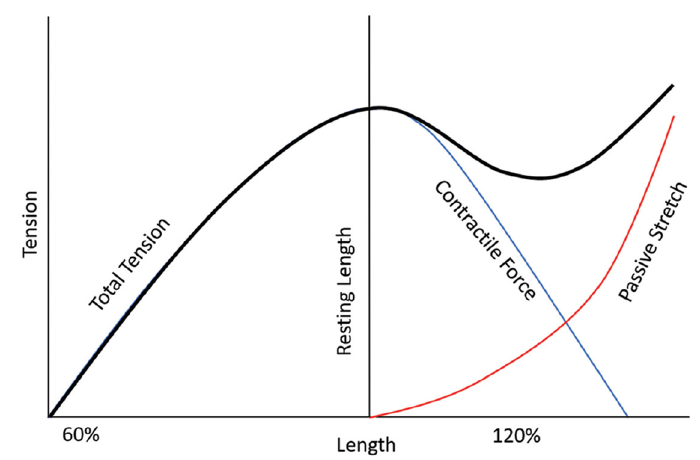
Figure 4. The Blix curve is the summation of two tension-length curves: one for active contraction and one for elastic recoil against the length. It demonstrates the greatest contractile force when stimulated at the resting length with a plateau of some length–distance change before the contractile force drops off. Figure reused from the article of Gardenier et al. [37].